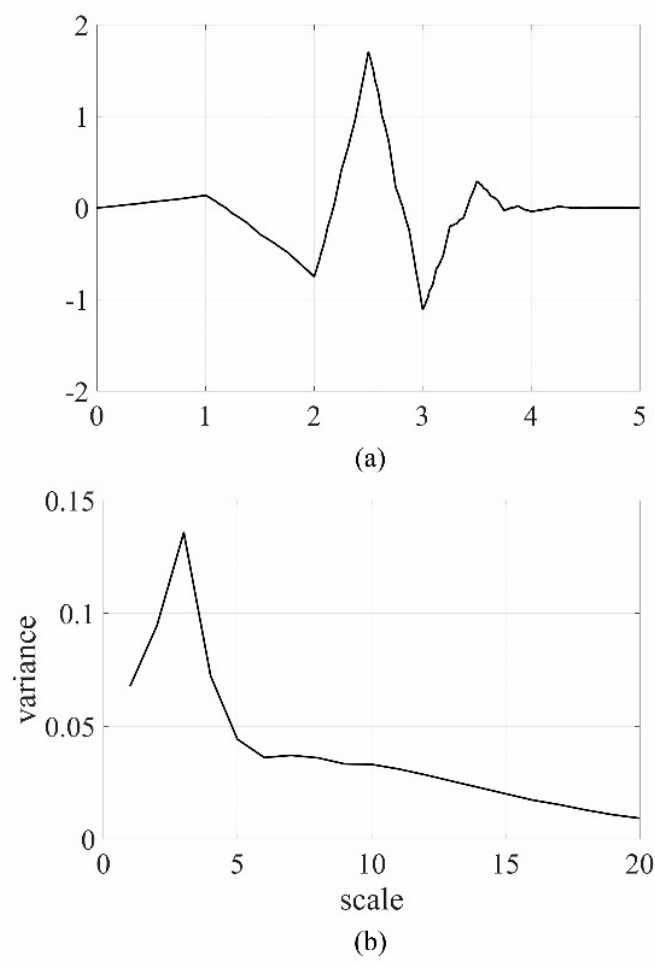
Figure 2. Wavelet filter and variance curve. ( a ) Wavelet function of the Daubechies-3 (db3) wavelet; ( b ) Variance curve of wavelet coefficients at different scales, using db3 filter.